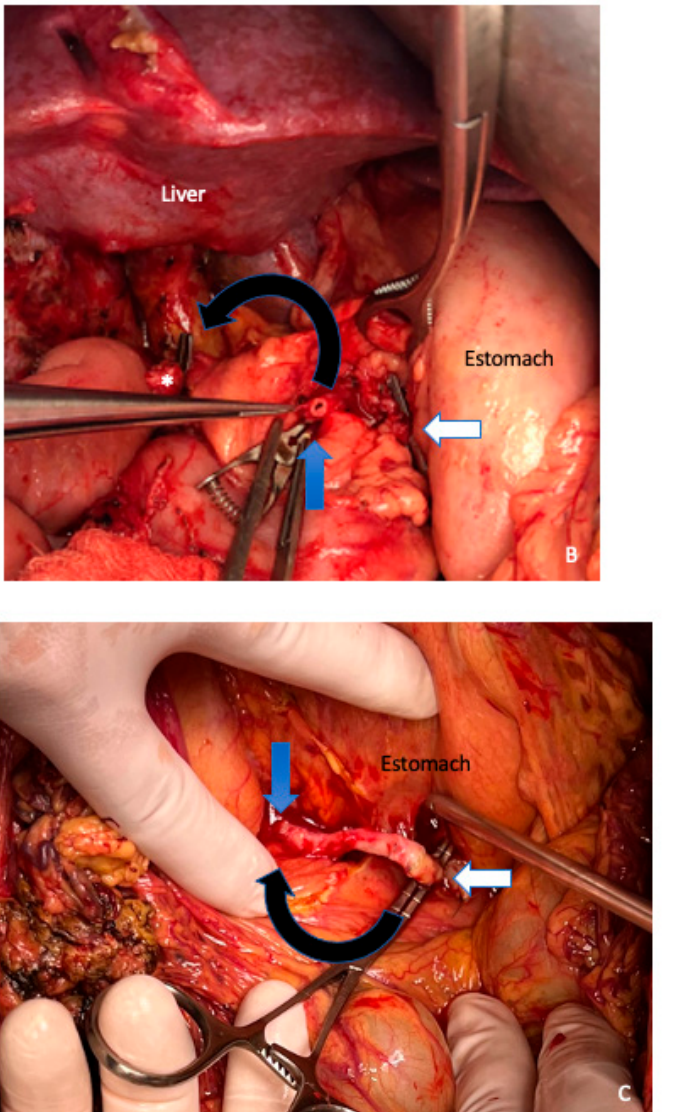
Figure 10. Splenic artery transposition technique with respective anastomosis with proper hepatic artery. ( A ) The right angle shows the splenic artery being dissected from its origin in the celiac trunk (blue arrow) distally (white arrow). The black arrow shows proper hepatic artery (bulldog clamp). ( B ) Section towards the distal portion of the splenic artery. The white arrow shows the distal end of the splenic artery that will be ligated. The blue arrow, the portion of the splenic artery that will be anastomosed to the proper hepatic artery (asterisk). The black arrow is marking the 180° rotation that the splenic artery will undergo to achieve a tension-free anastomosis. ( C ) Anastomosis between the splenic artery and proper hepatic artery. The white arrow is marking the clamp in the proximal segment of the splenic artery. The black arrow shows the 4 cm segment of the splenic artery that was rotated 180°, with the respective anastomosis to the proper hepatic artery (blue arrow). Recently, the technique of “arterial divestment” opens a great possibility for a peri- arterial neurolymphatic tissues dissection without the need of AR and respective recon- struction, with the risks that this implies. Arterial clearance is achieved by placing it in a plane between the uninvolved arterial wall and the tumor tissue of the affected arterial segment [43]. The dissection plane should be placed between the periarterial nerve plexus and the arterial adventitia (Figure